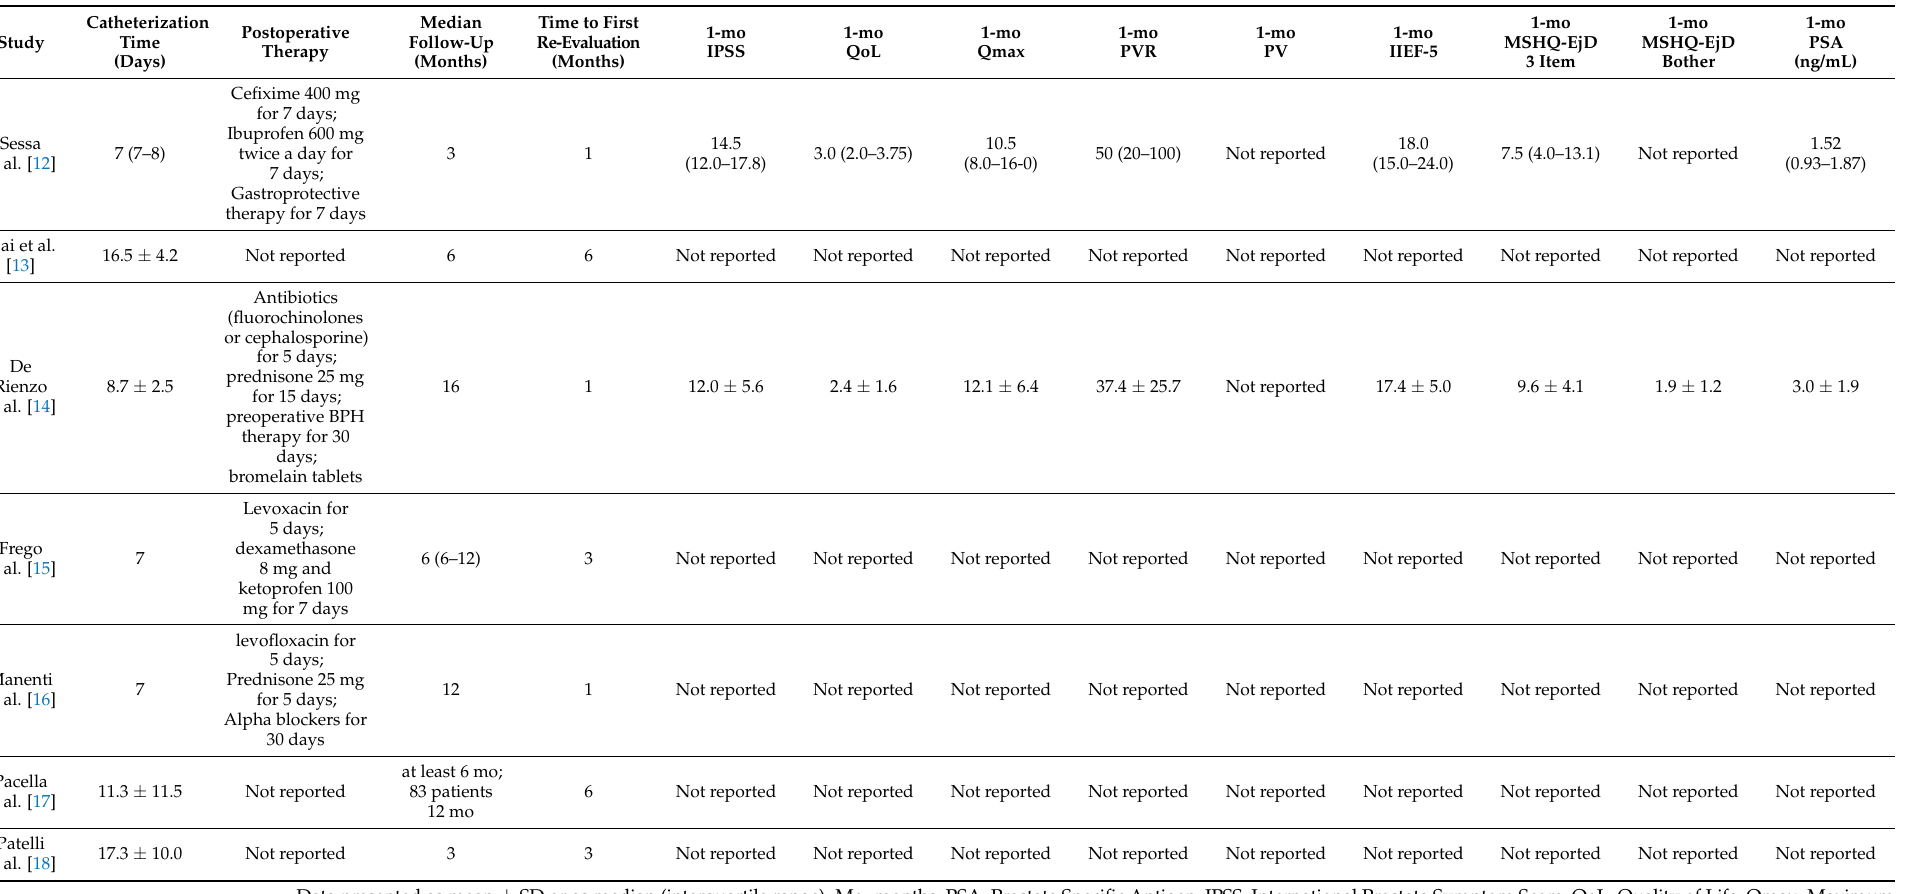
Table 3. Perioperative (<30 days) surgical and functional outcomes of studies on Trans Perineal Laser Ablation (TPLA) of prostate included in this